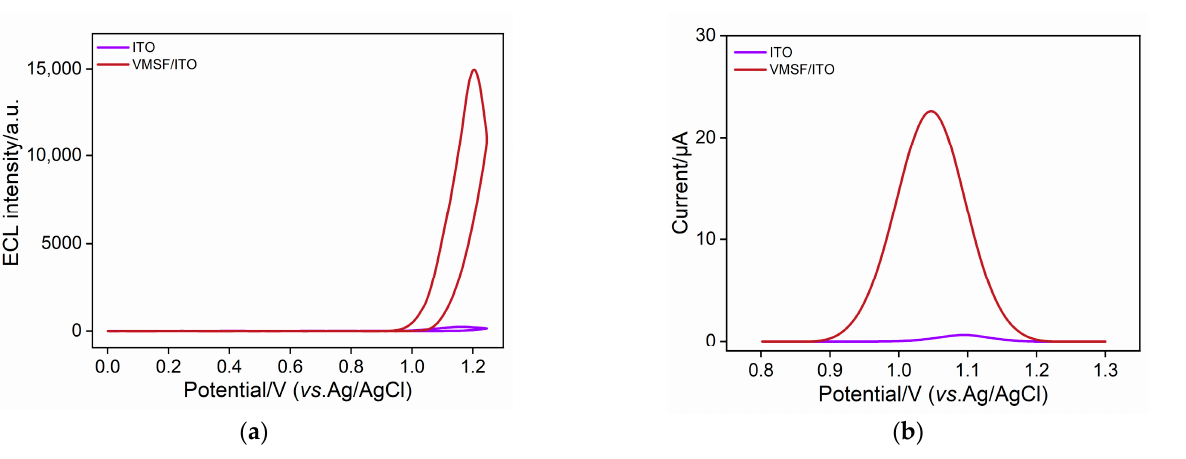
Figure 2. ( a ) ECL curves of ITO and VMSF/ITO in 10 μ M Ru(bpy) 32+ and 3 mM TPA; ( b ) DPV curves of ITO and VMSF/ITO in 10 μ M Ru(bpy) 32+ .